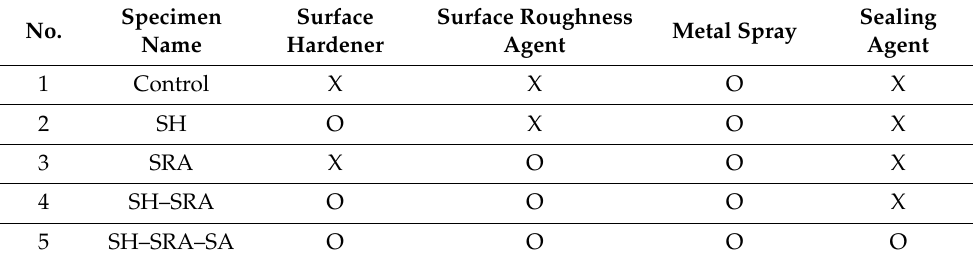
Table 1. Experimental variables. Specimen No. Name